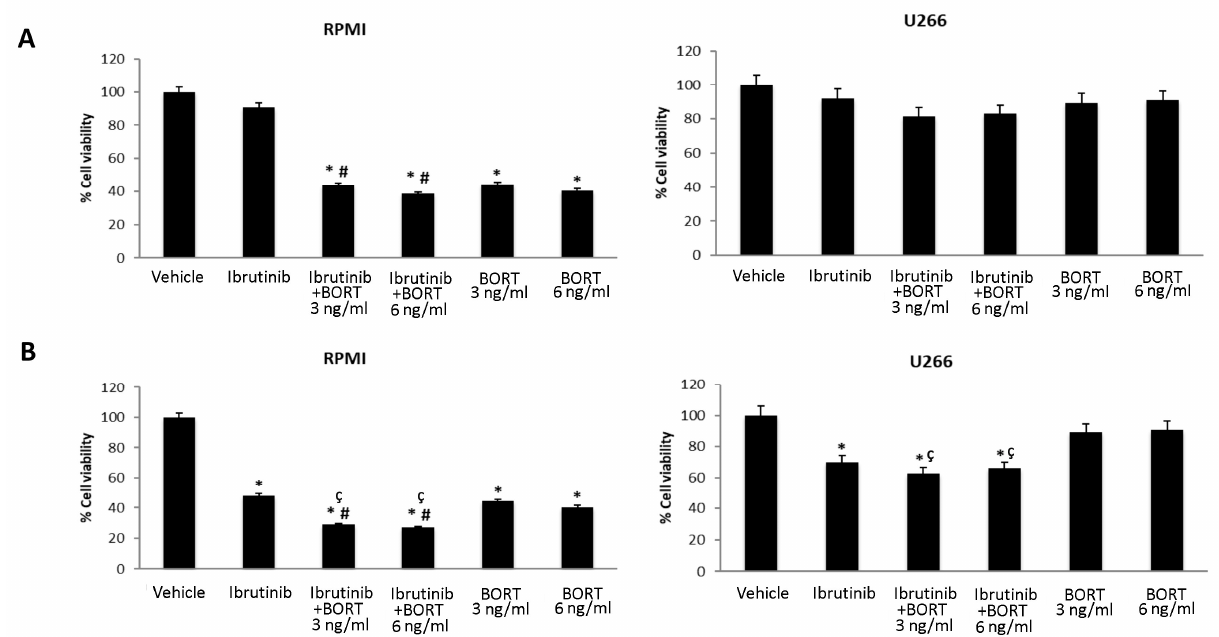
Figure 6. Cell viability assay in RPMI and U266 treated for 48 h with Bortezomib (BORT) in combination with Ibrutinib 5 μ M ( A ) and 12.5 μ M ( B ). Data are the mean ± SD of three different experiments. * p < 0.05 vs. vehicle, # p < 0.05 vs. Ibrutinib 12.5 μ M, ç p < 0.05 vs. BORT.